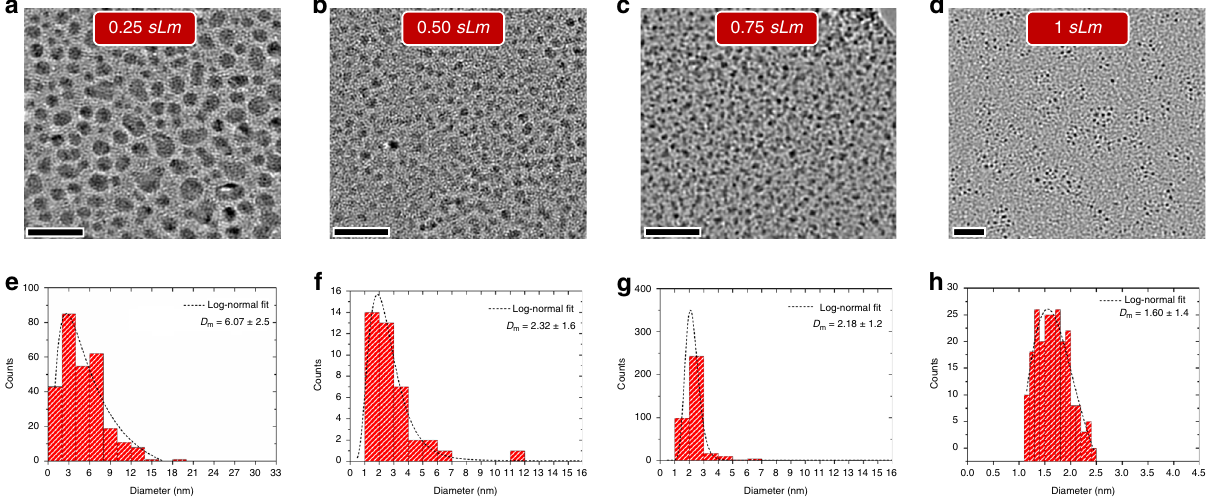
Fig. 2 Morphology of tin nanocrystals. a – d Transmission electron micrographs of Sn nanocrystals (NCs) prepared at 0.25 sLm, 0.5 sLm, 0.75 sLm and 1.0 sLm respectively; ( e – h ) bar charts showing size distribution of the NCs corresponding to the same micrographs in ( a – d ) with the average size of 6.07, 2.32, 2.18 and 1.60 nm respectively. The dashed curve represents the log-normal fi t to the distribution. The scale bars in ( a – d ) is equal to 20 nm and the sLm corresponds to standard liter per